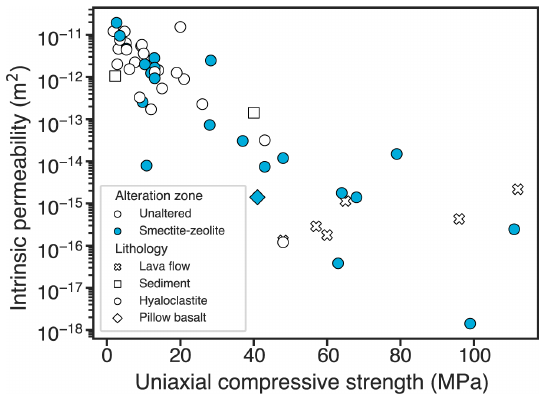
Figure 15. Permeability as a function of uniaxial compressive strength. Note that data are only available for unaltered rocks or samples that have been altered to smectite–zeolite conditions.